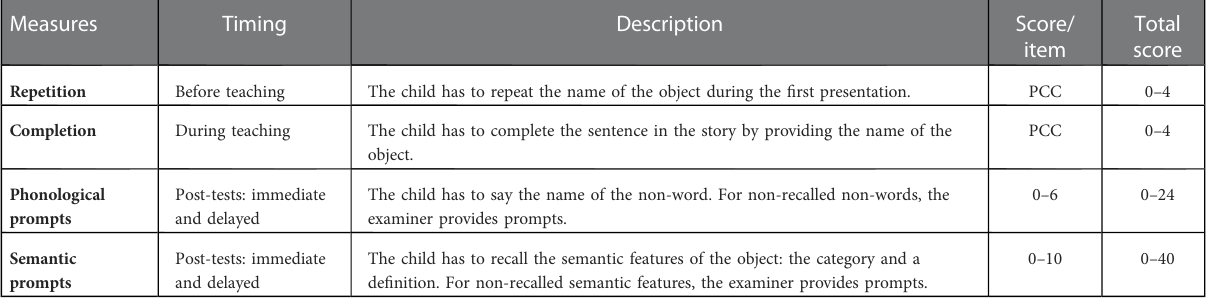
TABLE 5 DA: measures and